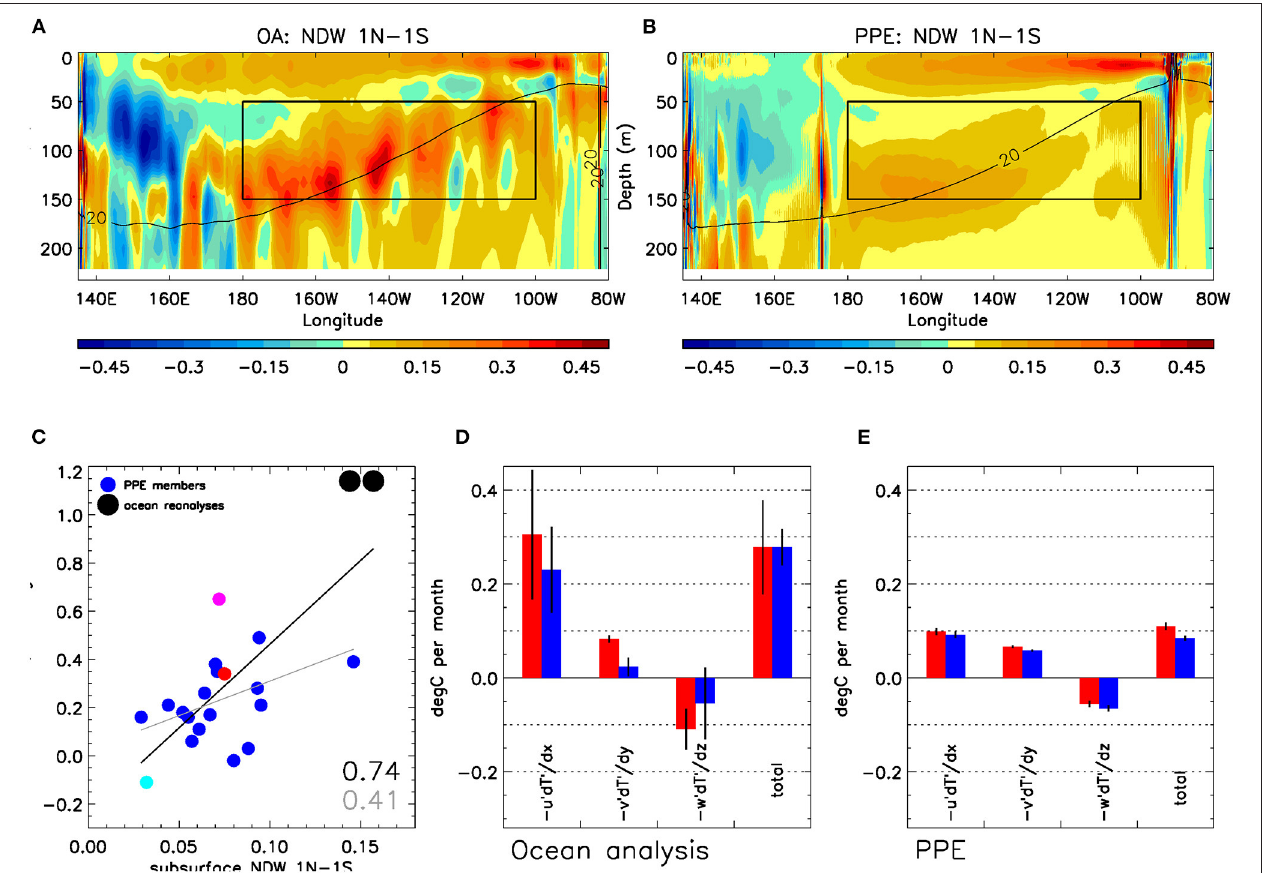
FIGURE 4 | Warming due to non-linear advection. Non-linear advection (K month − 1 ) for combined ocean analyses (A) and combined PPE members (B) . Box shows the averaging region for the non-linear advection. Scatter diagram of FEP skewness against non-linear advection for PPE ensemble members (small blue circles, with SK + magenta, STD red, SK– cyan) and ocean reanalyses (large black circles) (C) . Non-linear advection terms during growth period of El Niño (red) and La Niña (blue) for combined ocean reanalyses (D) combined PPE (E) . Combined results are the average over the respective datasets.The growth period is defined here as the average of months April to November prior to the event, with the DJF El Niño/La Niña events identified using a ± 0.8 ◦ C threshold. Data in (C) are area-averages taken over the box shown in the upper panels (180 ◦ -100 ◦ W,1 ◦ S-1 ◦ N, 50–150m). The combined ocean analysis data (A) have been smoothed. Vertical bars in (D,E) show the 95% confidence